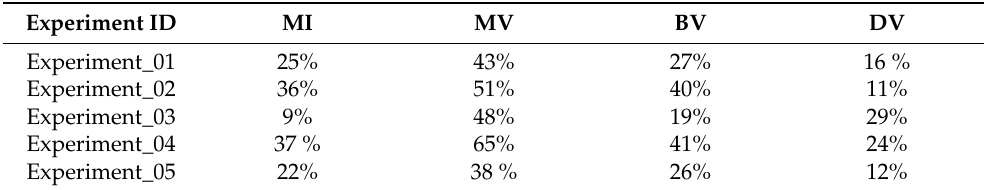
Table 3. The comparison results of algal-bloom recognition in algal areas. (MI is the result of manual interpretation; MV is the recognition result using the method described in [31]; BV is the recognition result of the proposed method; and DV is the errors of PA between the method described in [31] and the proposed method).